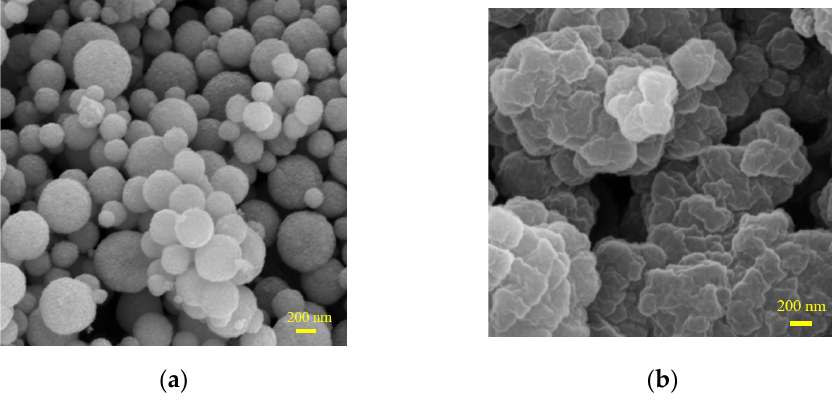
Figure 2. SEM images of ( a ) Fe 3 O 4 and ( b ) MMIPs.